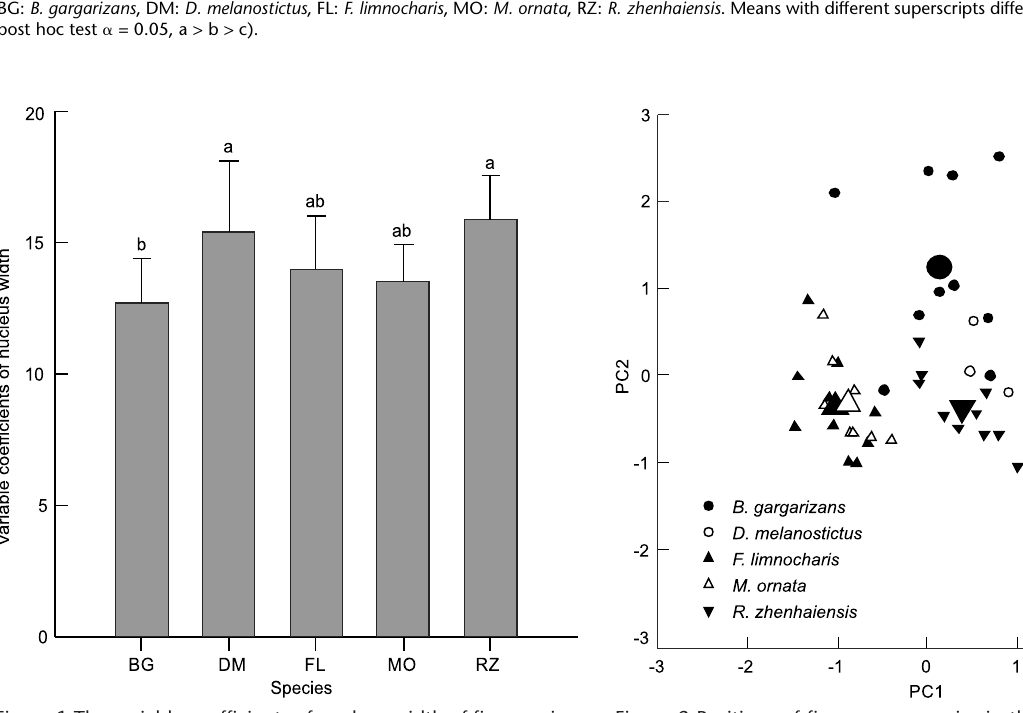
Figure 1 The variable coefficients of nucleus width of five species. Figure 2 Positions of five anuran species in the space defined by the first two axes of a principal component analysis based on nine variables of erythrocyte morphology. Enlarged symbols show the mean values of scores on the two